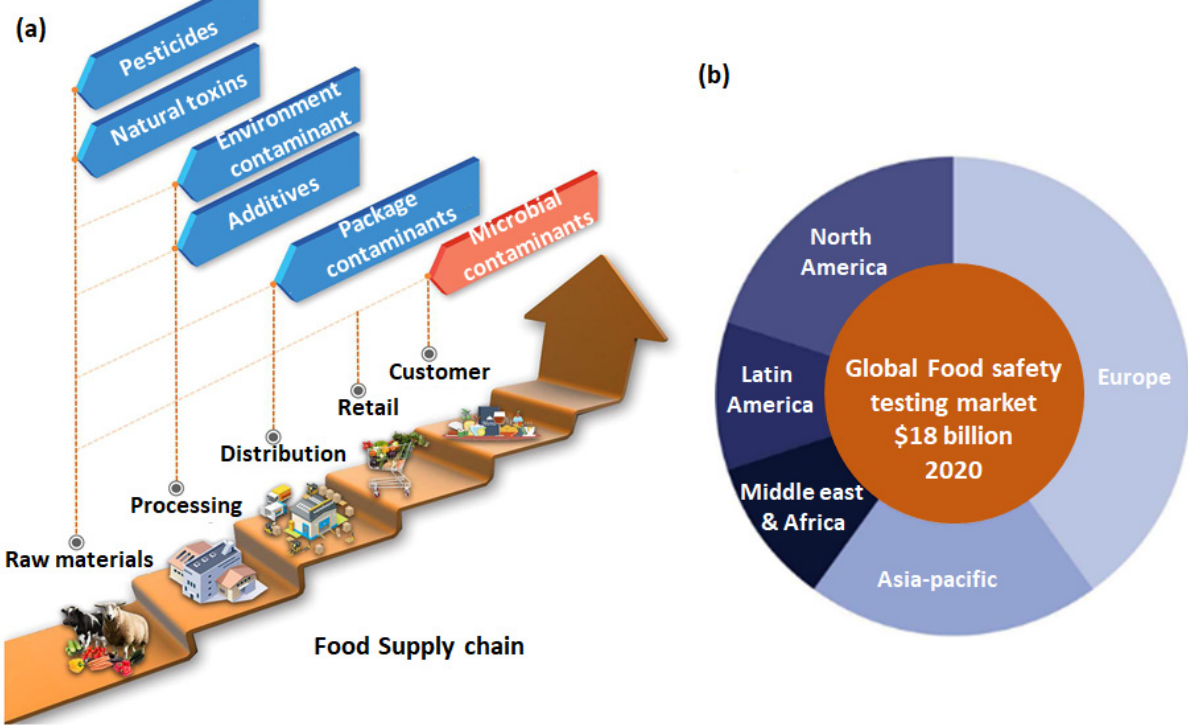
Figure 1. Scheme of the food supply chain and classification of potential contamination risks involved at different levels ( a ); adapted with permission from ref. [7]. schematic of global distribution in the food testing market ( b ).